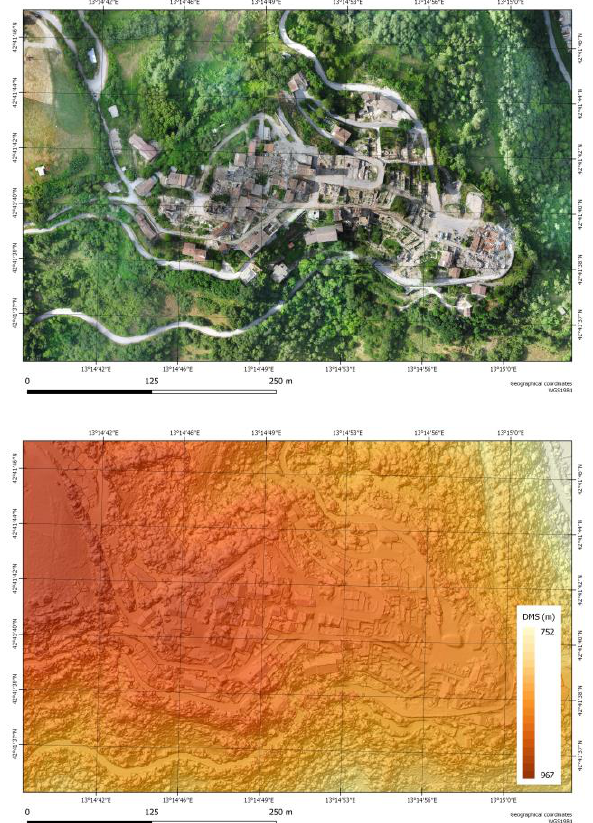
Figure 9. Mosaicked orthoimage (top) and DSM (bottom) covering the village of Accumoli. GSD = ~ 0.05 m